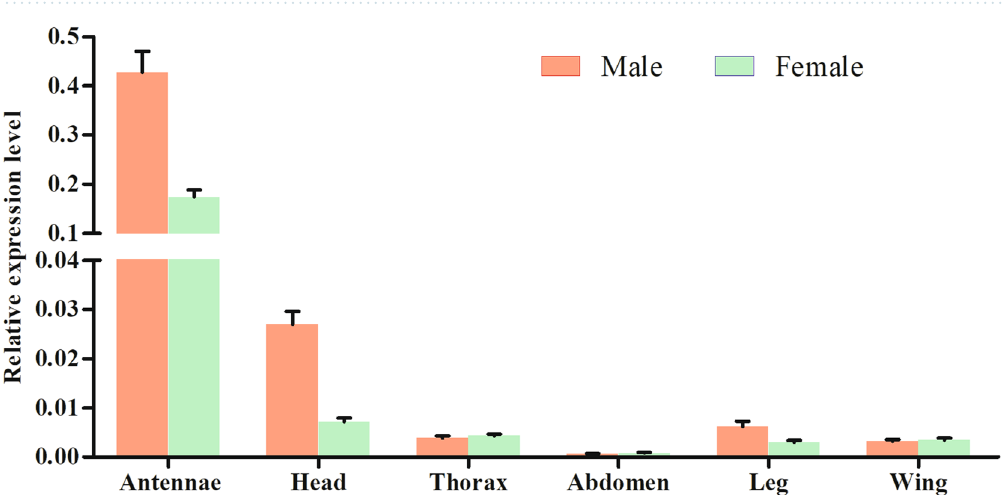
Figure 2. Multiple sequence alignment of OBPs from Lepidopteran insects including MvitOBP3.